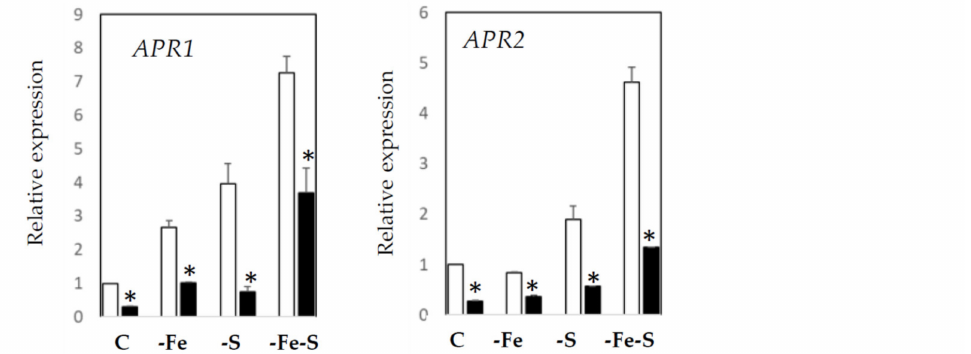
Figure 3. Expression of S deficiency-induced genes in Arabidopsis thaliana seedlings grown under full nutrient conditions (C), absence of iron (-Fe), absence of sulfur (-S) and combined Fe and S deficiency (-Fe-S). Plants were exposed for 7 days both to GMF and NNMF conditions. Expressions of SULTR 1;1, SULTR1;2, SULTR 1;3 and APR1 were reported in the upper panel while expressions of SULTR 2;1, SULTR 2;2 and APR2 are reported in the lower panel. Data are from three independent experiments ( n = 3). Values are expressed as fold changes ( ± SE) with respect to control plants growing in GMF conditions under full nutrient media (C). Asterisks indicate significant (p < 0.05) differences between NNMF and GMF exposed plants. Two-way ANOVA results are reported in Table